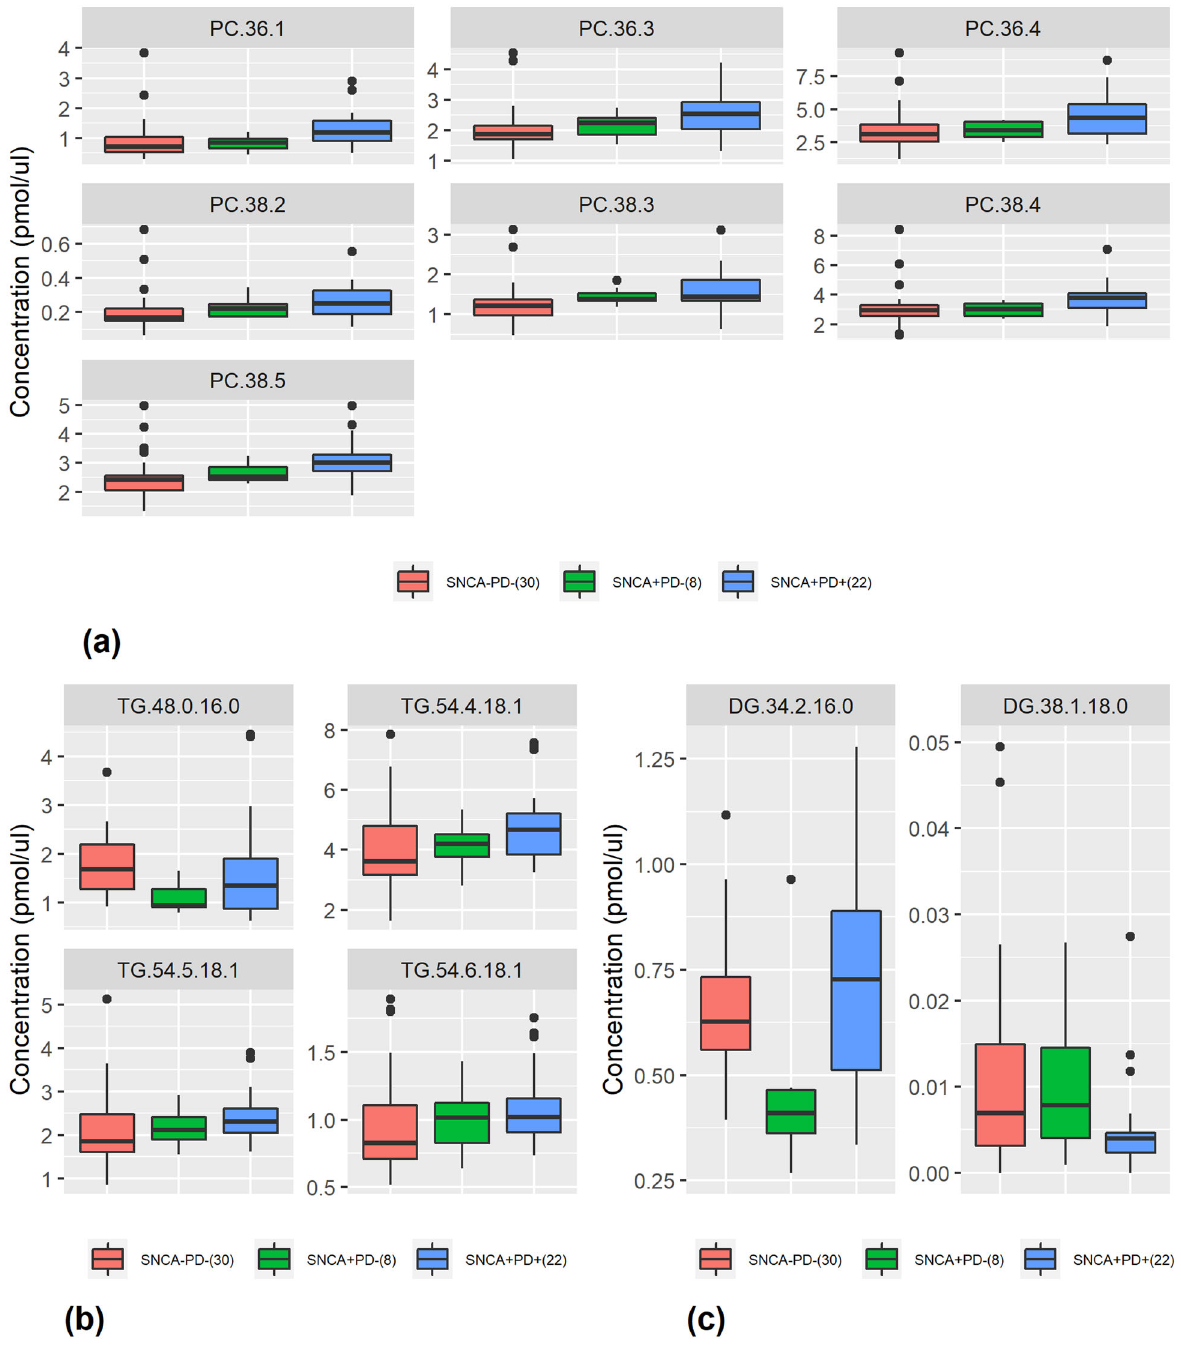
Fig. 2 Serum concentrations for contributing glycerophosphatidylcholine, triradylglycerol, and diradylglycerol species. a – c Concentrations for all contributing glycerophosphatidylcholine (PC), triradylglycerol (TG), and diradylglycerol (DG) species in Table 2. Note that subjects of the SNCA + /PD − group were not part of the analysis and are shown here only for comparison with the other two groups of subjects. Note that in all the PC and most of the other species, SNCA + /PD − is shown as an intermediate state between the controls and SNCA + /PD + group. The center line represents the median, the bounds of the box are 25th percentile (Q1) and 75th percentile (Q3), the whiskers are Q1 − 1.5*IQR and Q3 + 1.5*IQR, and the dots are